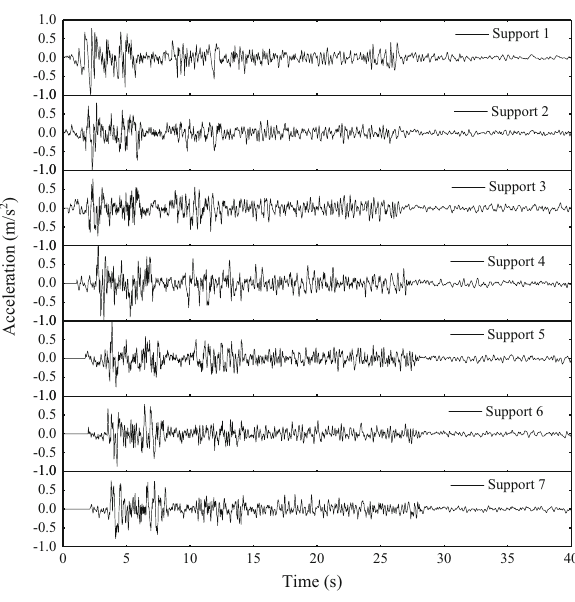
Fig. 10 The given and simulated ground motions of case